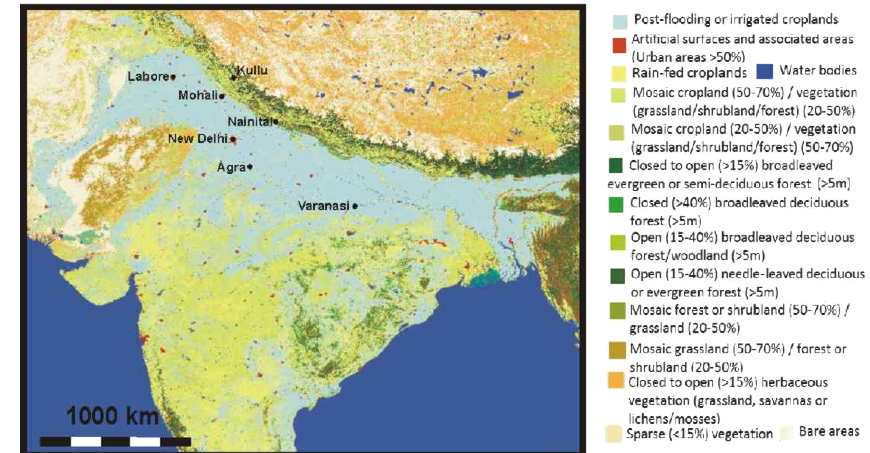
Figure 1. Location of our site and surrounding sites for which ozone measurements have been reported, superimposed on a land classification map (courtesy ESA GlobCover 2009